Question: What does this figure show? Answer in one sentence.
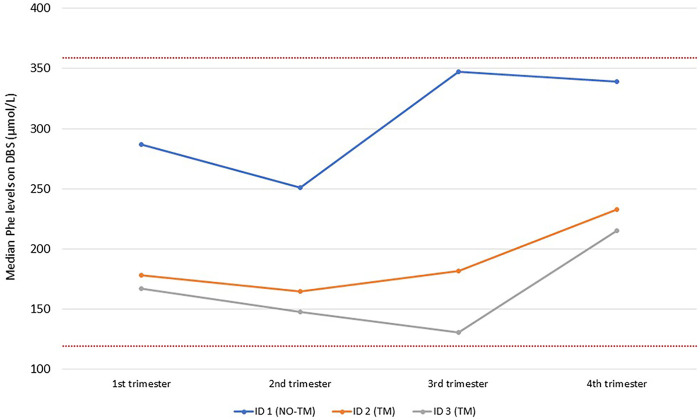
Answer: Median phenylalanine values trends on dried blood spot at each trimester of the three enrolled patients with phenylketonuria (ID 1-3) during their first year of life. The area within dashed lines represents the reference value range for age according to European guidelines (120-360 µmol/L) ( 22 ). Phe, phenylalanine; DBS, dried blood spot; ID, identification number; TM, received nutritional consultations through telemedicine; NO-TM, did not receive nutritional consultations through telemedicine.